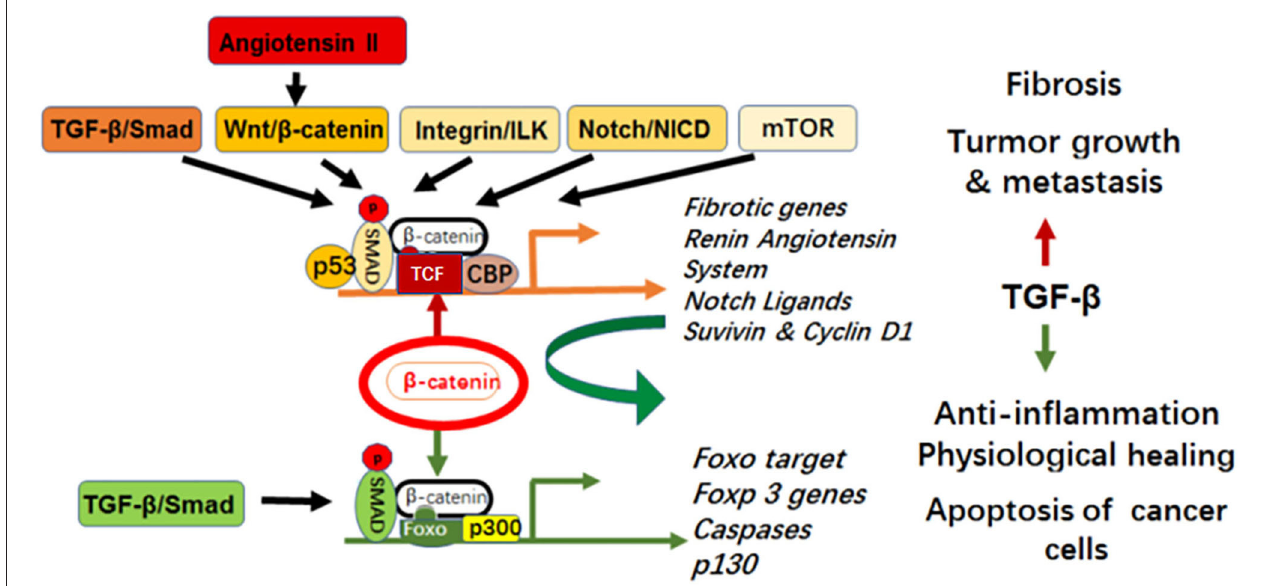
FIGURE 1 | Cell specific cross-talking pathways in fibro-inflammatory disease and cancer.